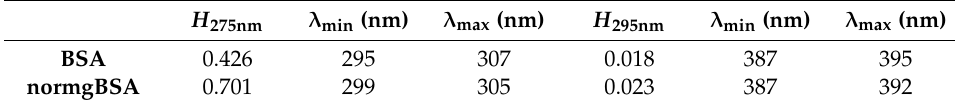
Table 2. Relative peak composition (parameter H ) of bovine serum albumin residues at λ ex = 295 nm and λ ex = 275